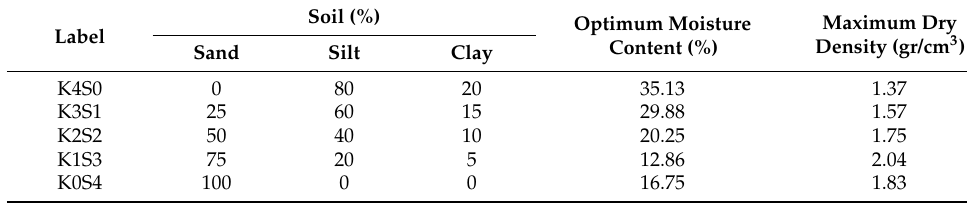
Table 3. Sand-kaolinite